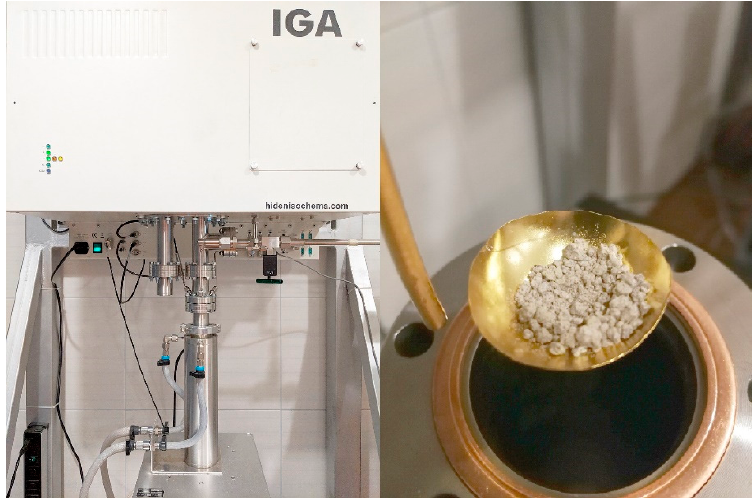
Figure 1. IGA 001 gravimetric gas sorption analyser .